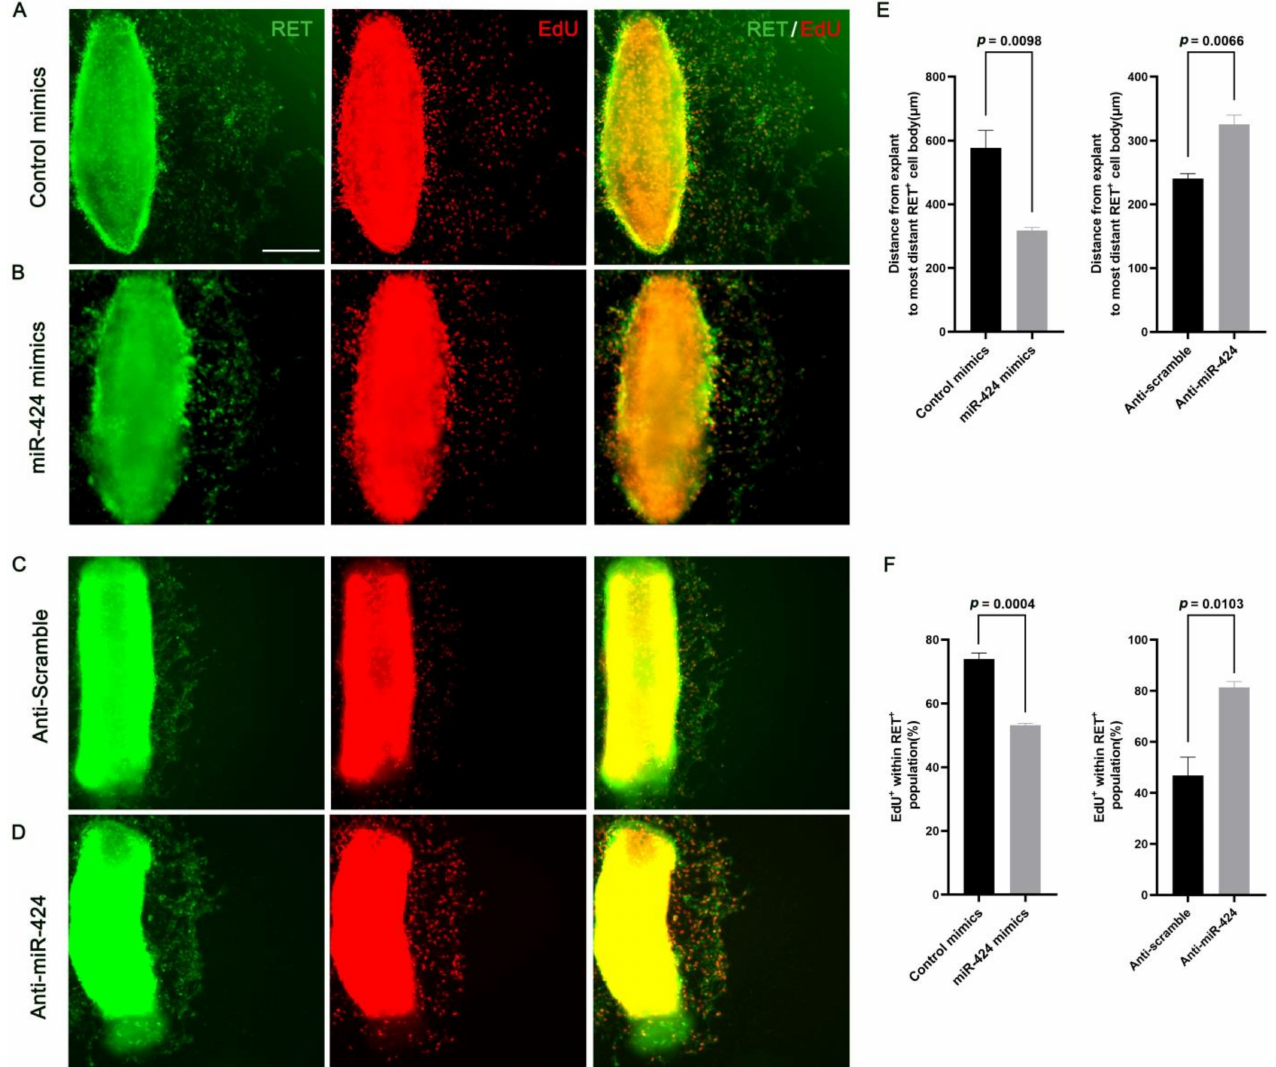
Figure 7. miR-424 regulates ENCC migration and proliferation in explant cultures. ( A – D ) Repre- sentative views of E12.5 midgut explants that were cultured for 24 h and immunostained for RET and EdU. The explants are at the left of each image. Scale bar = 200 µ m. ( E ) Quantitative analysis of the distance traveled by the RET-expressing cells furthest from the edges of the explant after 24 h in culture. ( F ) Quantification of EdU labeling index within the RET-expressing population after 24 h in culture. Error bar = SEM (standard error of the mean); n =